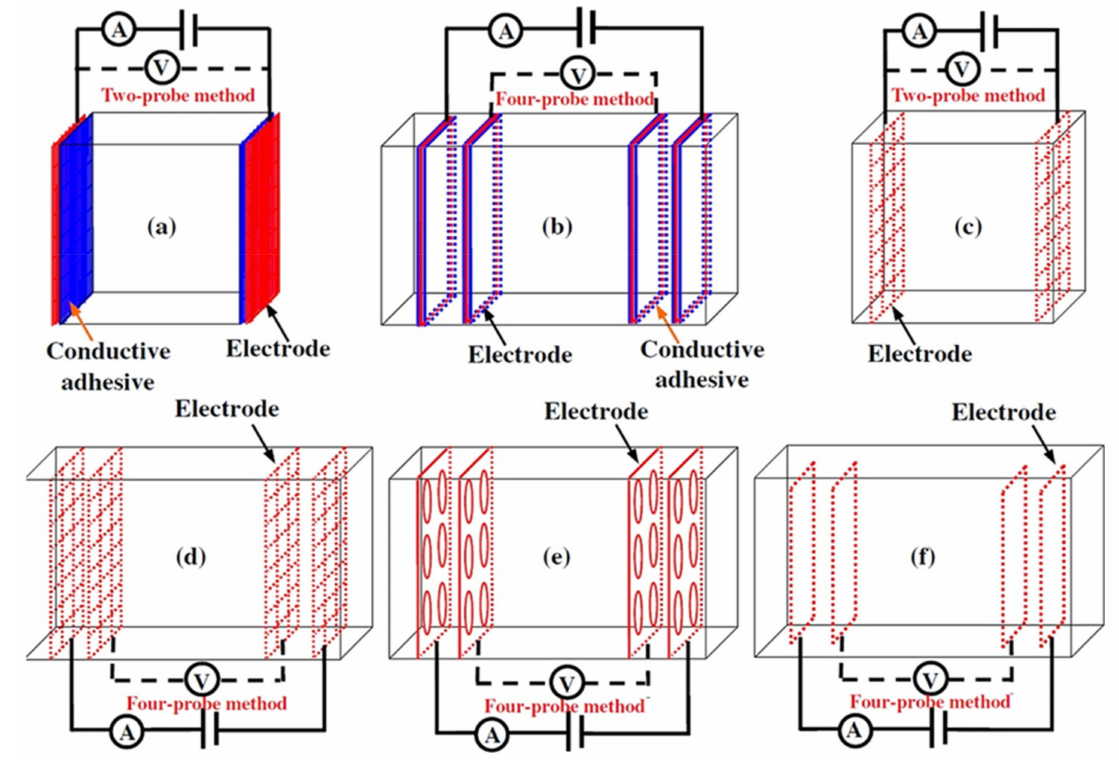
Figure 10. Schematic diagram of electrode configurations: ( a ) two-probe method, and ( b ) four-probe method with the attached electrode; ( c ) two-probe method, and ( d ) four-probe method with the copper mesh embedded electrode; ( e ), ( f ) the em-bedded electrode four-probe method with enlarged copper mesh opening (reprinted with permission from [8] ©2019 with permission from